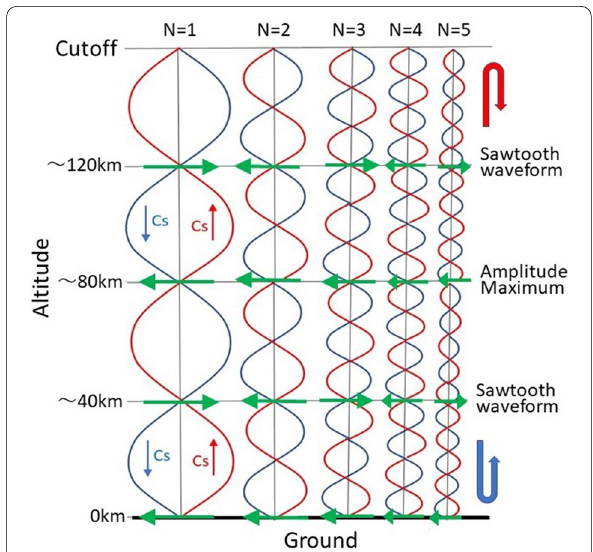
Fig. 13 A simple model of vertical acoustic resonance. At a certain moment shown in this figure, we assume that all of the harmonic waves for upward or downward propagating waves have the same phase at the ground. The green arrows indicate the direction of phase variation at this moment for each harmonic wave